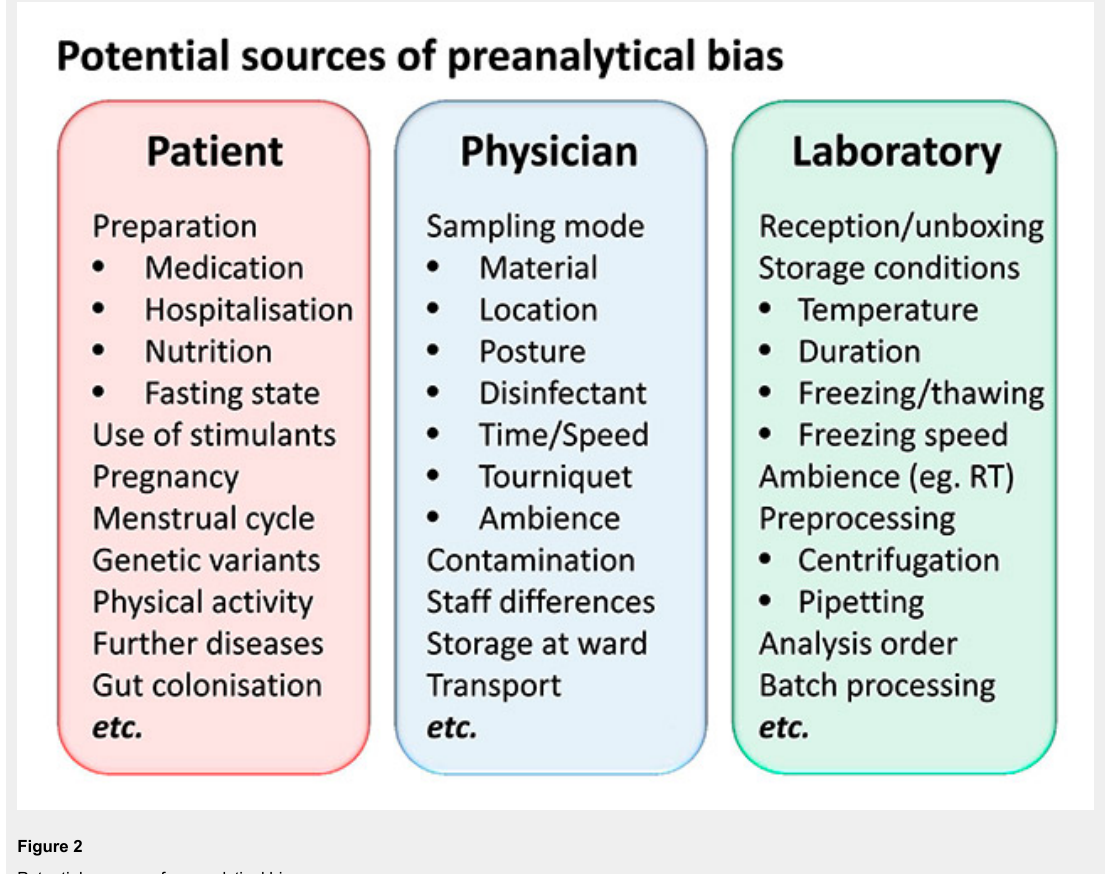
Figure 2 Potential sources of preanalytical bias. RT = room